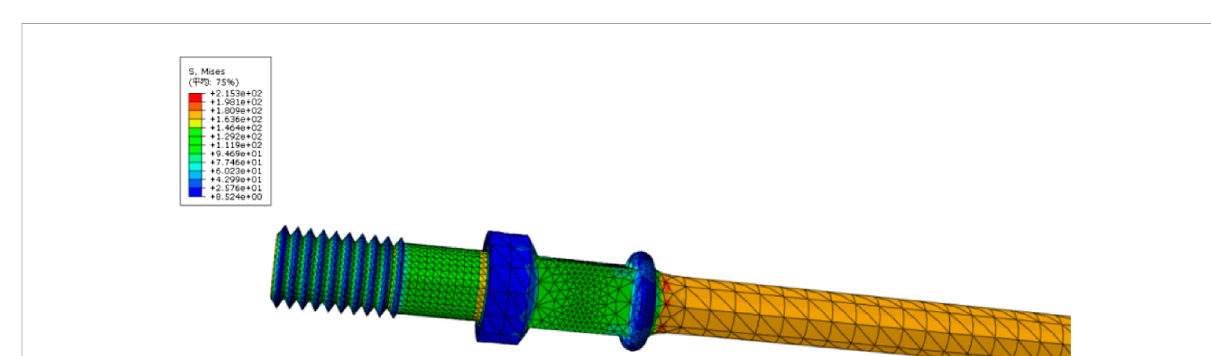
FIGURE 10 Pumping rod equivalent force cloud.